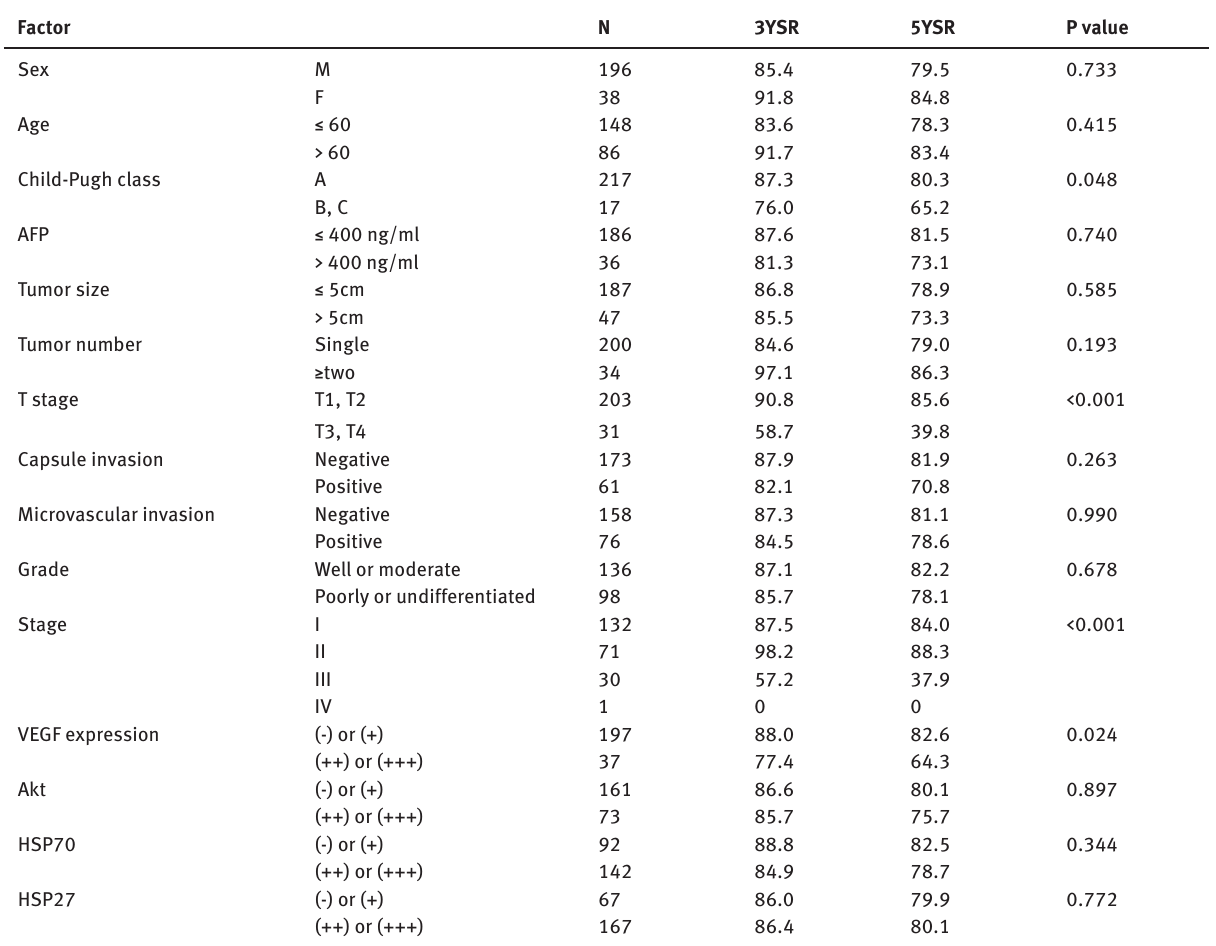
Table 2: Clinicopathological and immunohistochemical prognostic factors affecting on overall Survival